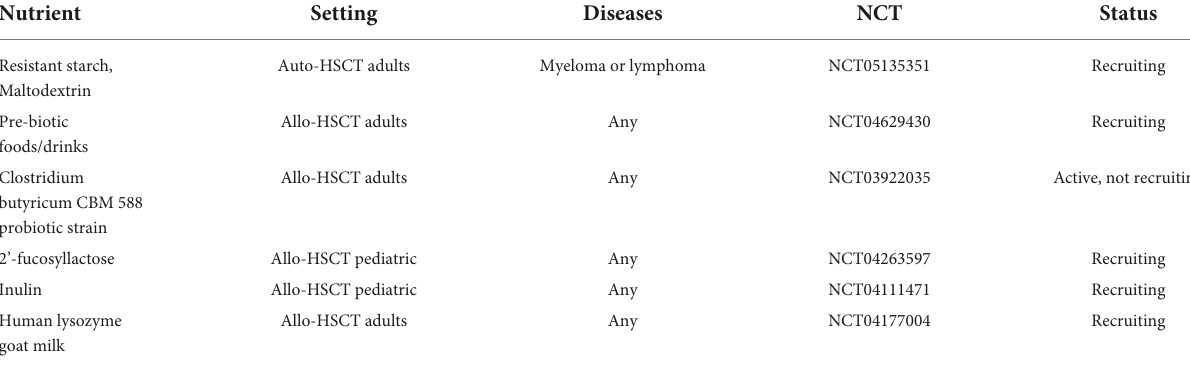
TABLE 2 Ongoing trial for GM modulation in